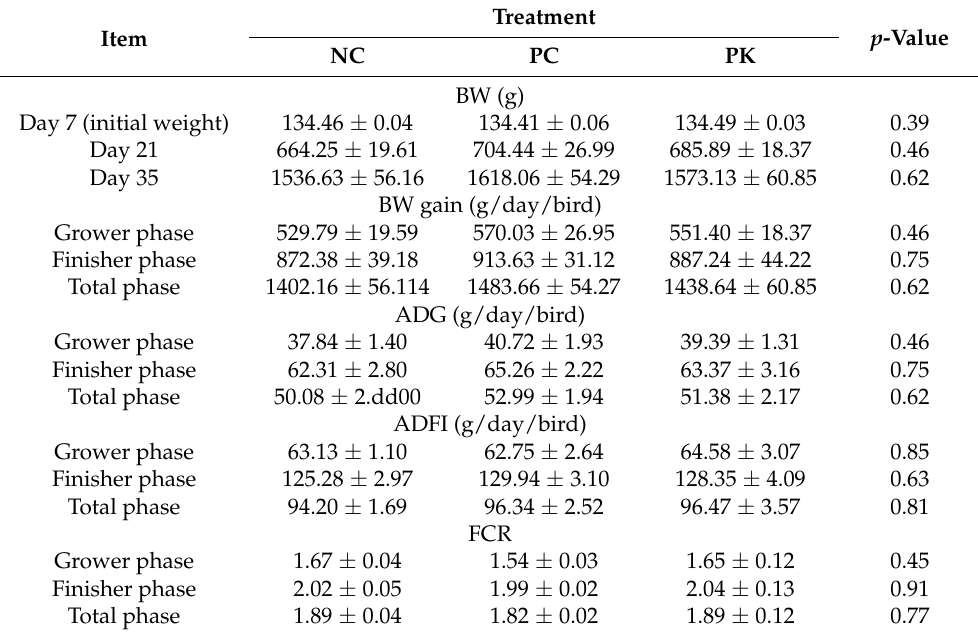
Table 3. Dietary supplemental effect of P. konkukensis on growth performance in broilers. Item